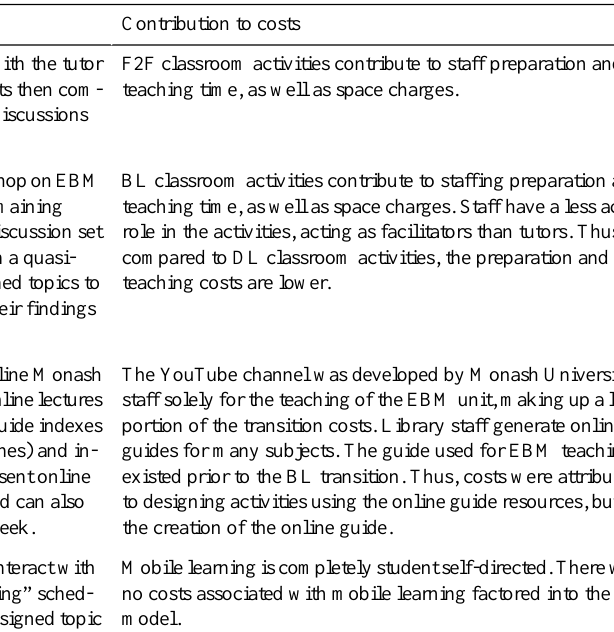
Table 1. Detailed description of the DL and BL teaching approach to EBM with associated costs.